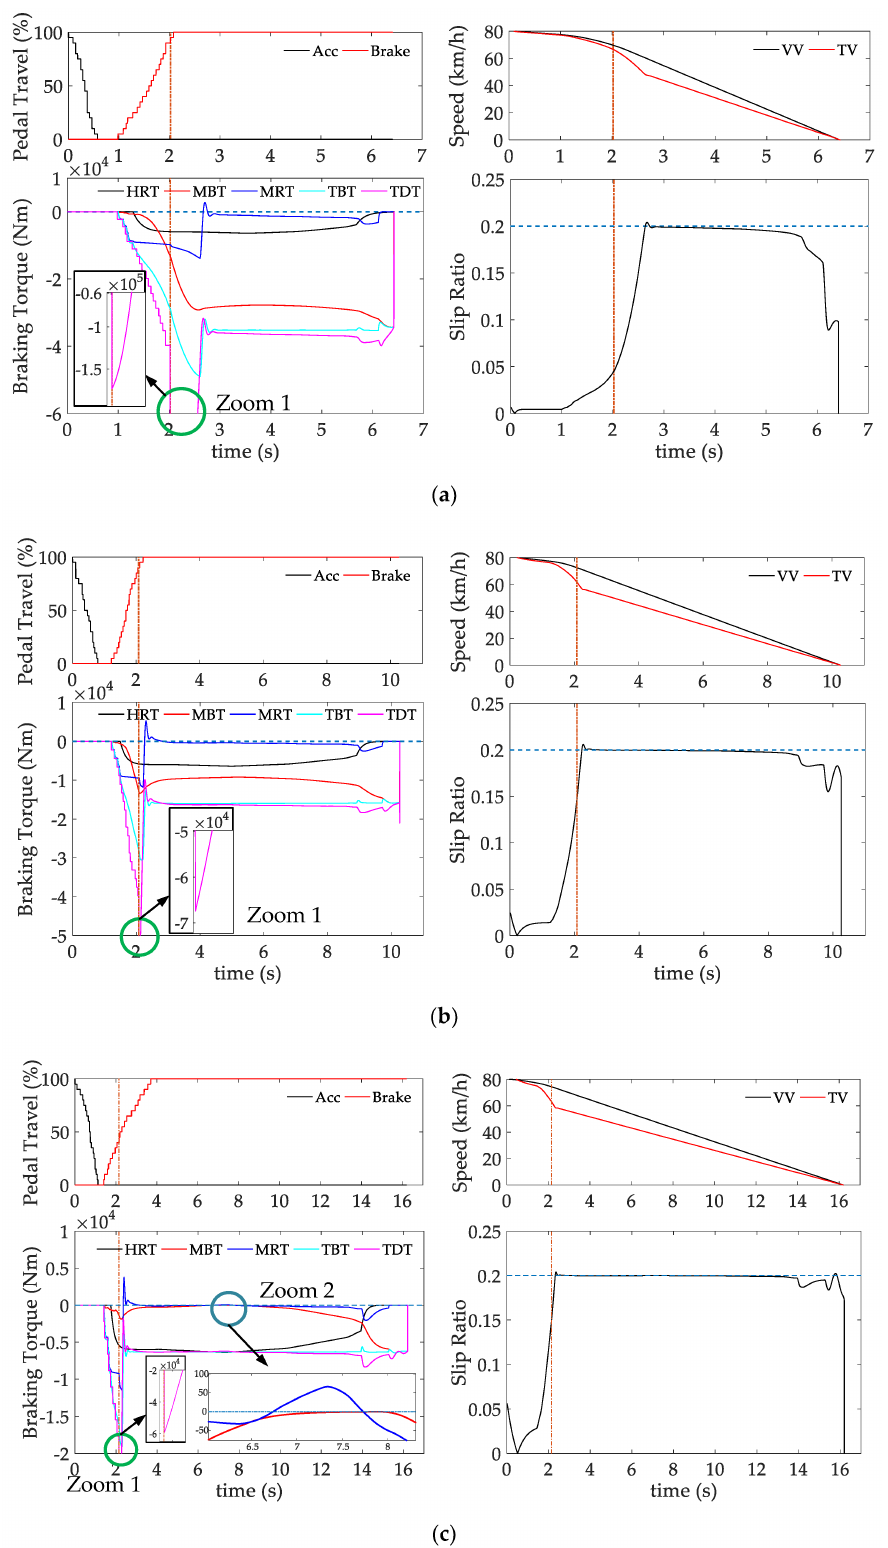
Figure 10. Experiment results of the proposed emergency braking control strategy under three track-ground conditions. They are respectively the curves of accelerator pedal and brake pedal travel, vehicle and track speed, braking torque, and the slip ratio of: ( a ) a muddy road; ( b ) snow; ( c ) ice. Acc, Brake, TBT, and TDT represent acceleration pedal travel, braking pedal travel, total braking torque, and total demanded braking torque,